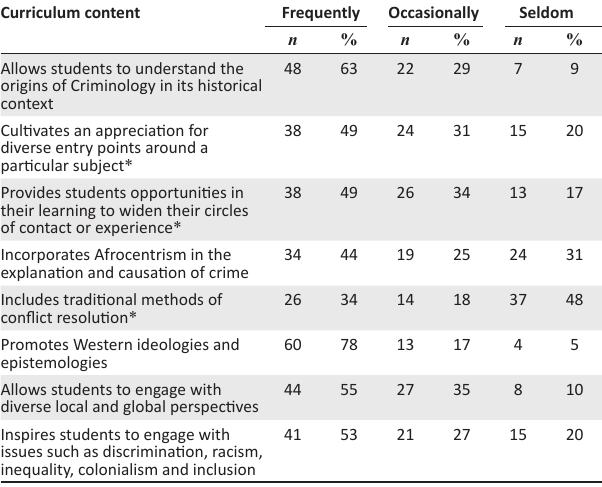
TABLE 3: Content of Criminology